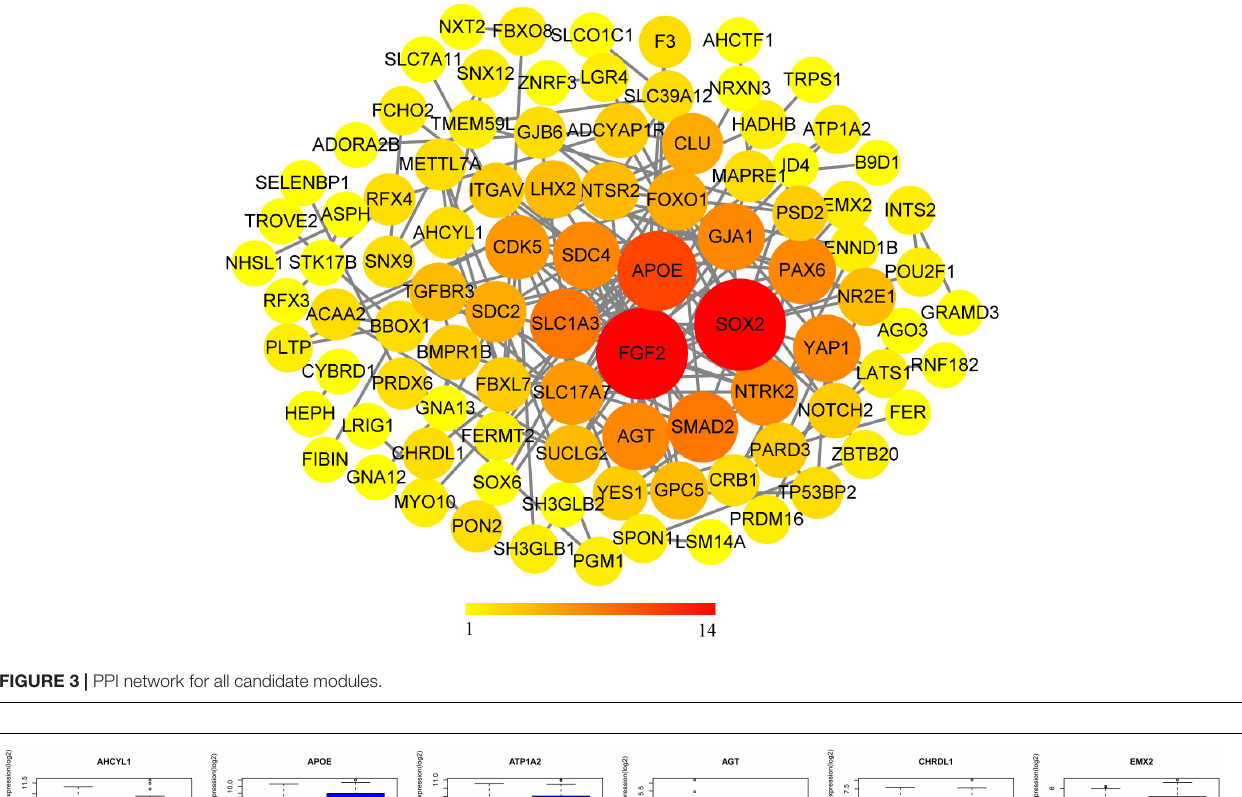
FIGURE 3 | PPI network for all candidate modules.